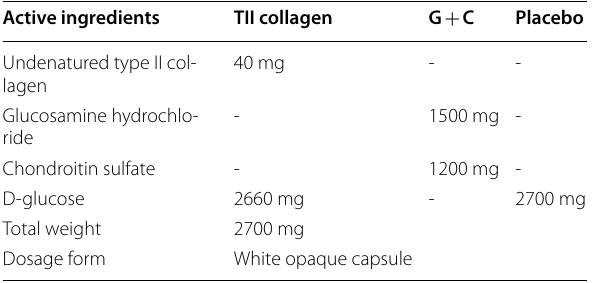
Abbreviation: G C Glucosamine hydrochloride and Chondroitin sulfate +